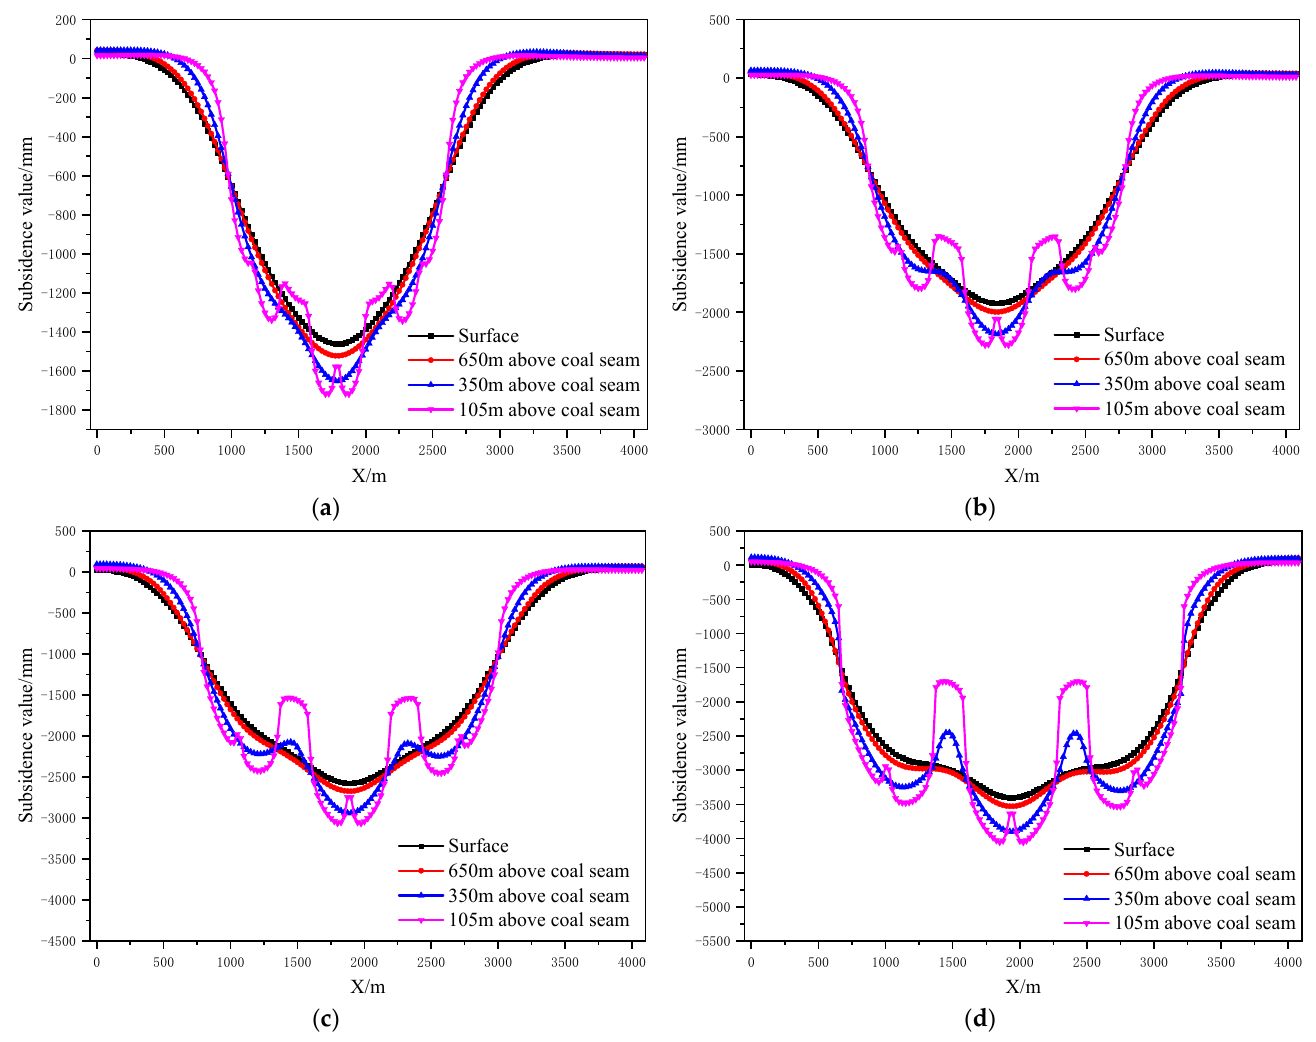
Figure 13. Strata and surface subsidence rule of partial filling mining based on the main key stratum under different caving face scales; ( a ) width of caving face = 200 m. ( b ) Width of caving face = 250 m. ( c ) Width of caving face = 300 m. ( d ) Width of caving face = 350 m.